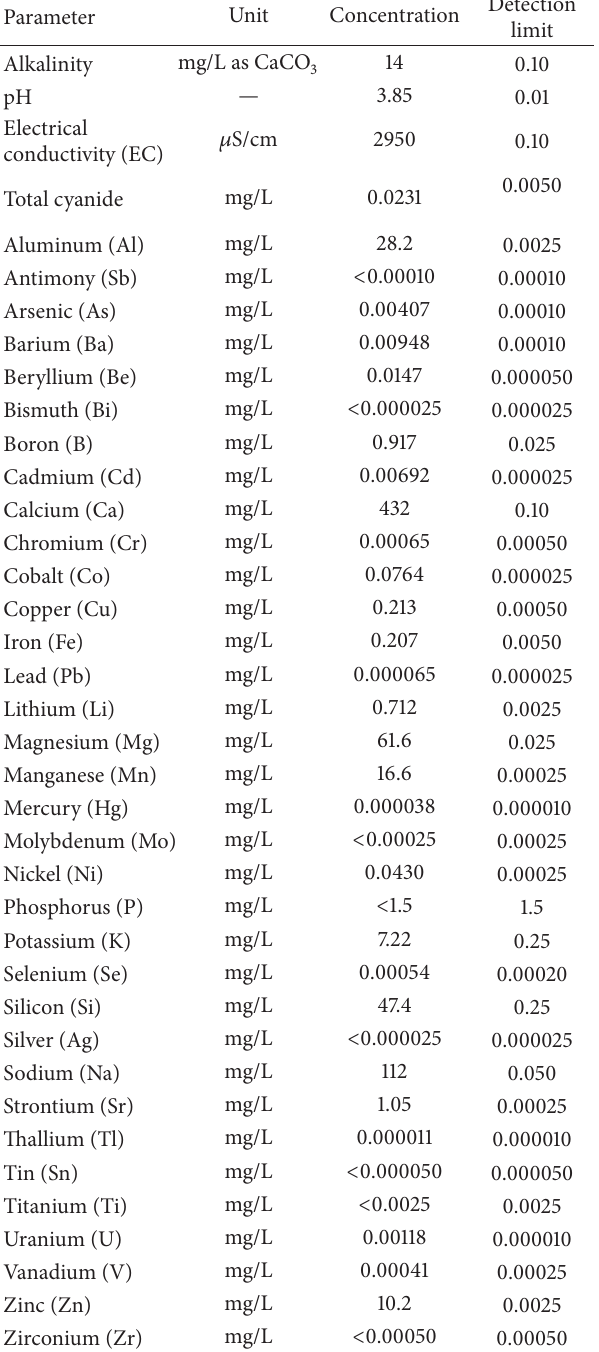
Table 2: Composition of the treated water collected from the water treatment